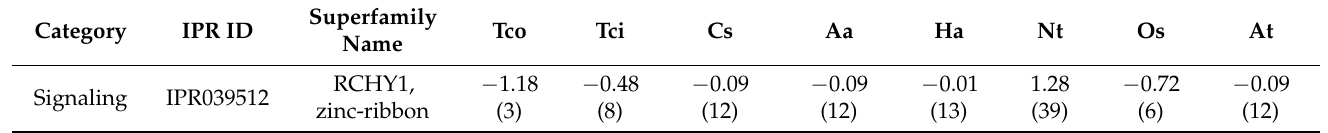
Table 7. Superfamilies with the lowest multiplication odds scores in T. coccineum .